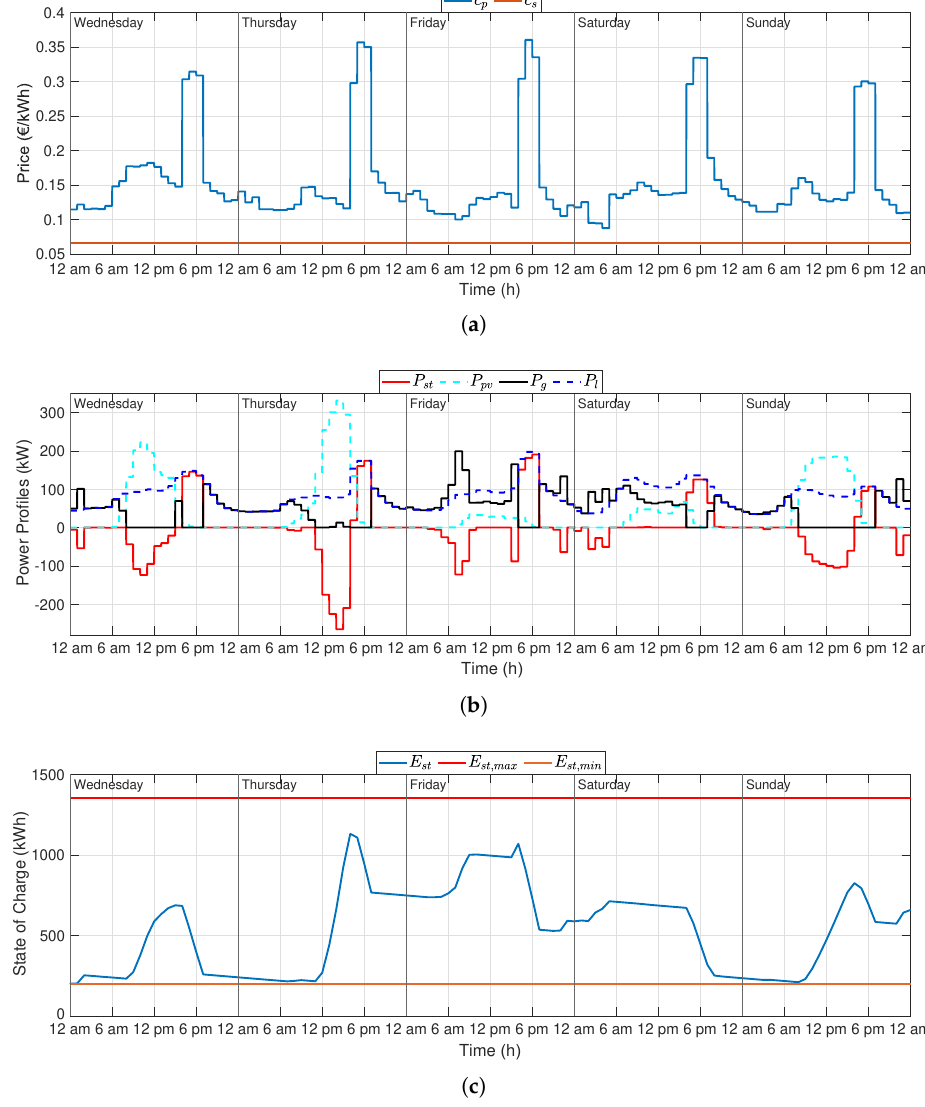
Figure 9. MPC results with Great Britain prices in a simulation of five days: ( a ) Cost and revenue of energy; ( b ) Power Profiles; ( c ) State of